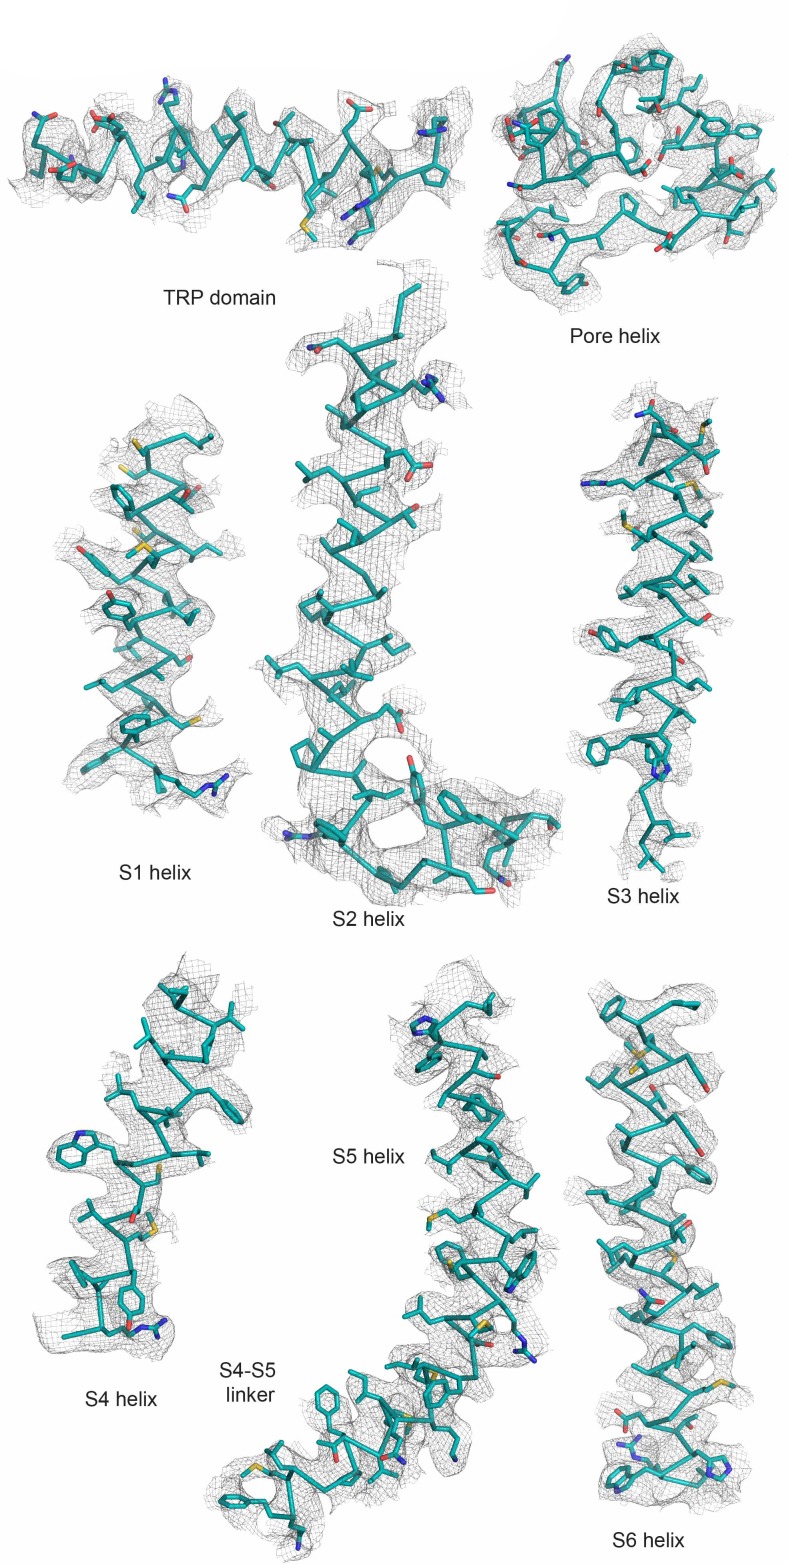
Data quality of ZINC9155420-bound TRPV5 in nanodiscs.Various helices of ZINC9155420-bound TRPV5 shown as atomic models (teal ribbons) with the corresponding cryo-EM density (gray mesh).